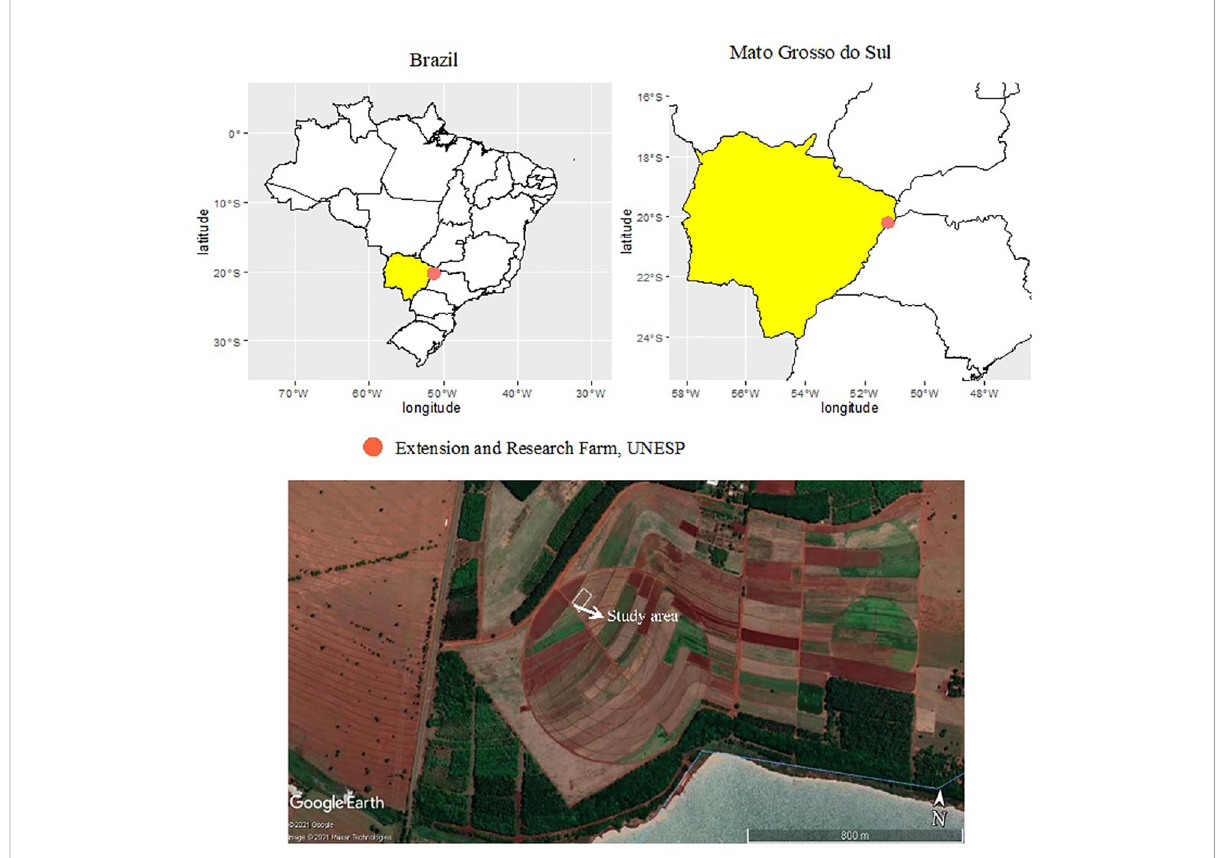
FIGURE 1 Geographical location of experimental site at Extension and Research Farm, UNESP – Ilha Solteira, at Selv ı ́ ria, state of Mato Grosso do Sul, Brazil (20°22 ′ S, 51°22 ′ W, altitude of 335 m) during the 2019 – 20 and 2020 – 1 cropping seasons. The map was created using pacot, geobr, and ggplot within R software (R Core Team, 2015). Accessed on 27 February 2022. Projection System WGS 84/UTM 200DC [EPSG: 4326]. This image was taken from the Google Earth program, Google Company (2021). Map data: Google, Maxar